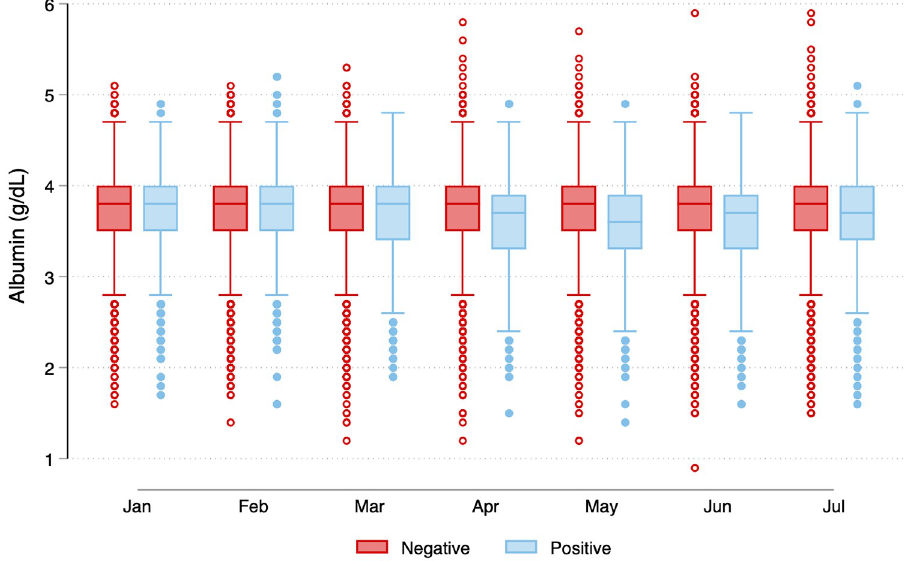
Fig 2. Serum albumin concentrations among patients with and without SARS-CoV-2 antibodies in July 2020. Among patients who did not have SARS-CoV-2 antibodies in July, the serum albumin concentrations remained stable between January and July 2020 (median 3.8 [25 th , 75 th percentile, 3.5, 4.0] g/dL). For patients with SARS-CoV-2 seropositivity in July, median serum albumin concentrations were identical to the group without antibodies in January and February. However in the group with seropositivity in July, median albumin concentrations started to drop in March, with the lowest concentrations observed in May (median 3.6 [25 th , 75 th percentile 3.3, 3.9] g/dL). In any given month, a patient could contribute more than one observation as multiple laboratory draws were possible. For patients seronegative for SARS-CoV-2 in July 2020, N by month were 22395, 23127, 24035, 24612, 25369, 25994, and